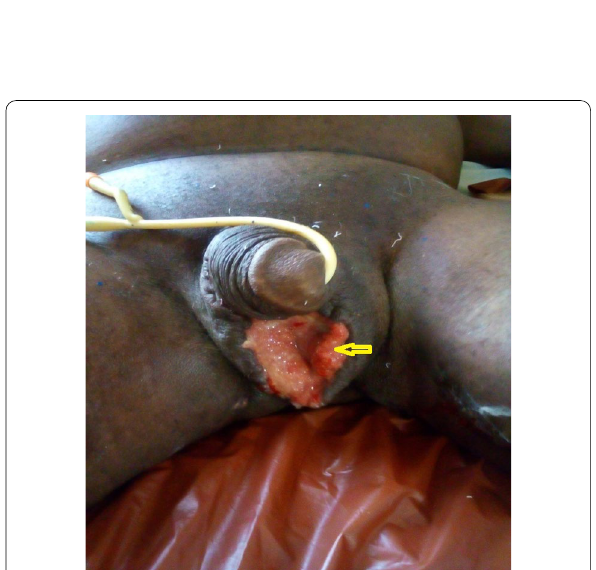
Fig. 8 The edge of the retracted muscle following debridement